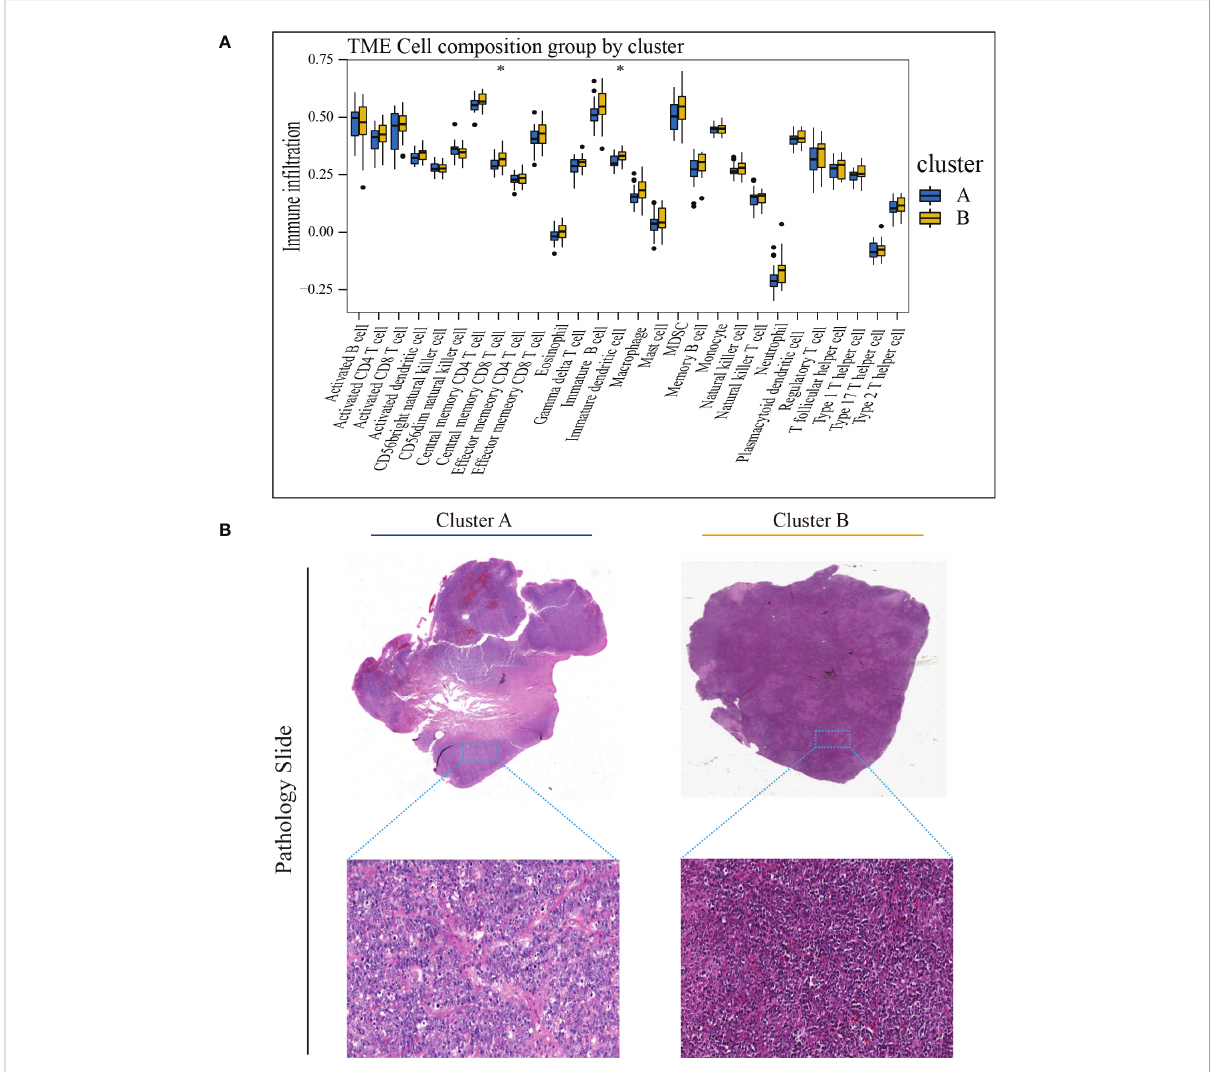
FIGURE 4 Characteristics of TME in the cuproptosis subtypes of TCGA-DLBCL. (A) The abundance of different in fi ltrating immune cells in the two clusters. (B) Representative images of pathological H&E staining of two cuproptosis subtypes. * P < 0.05; ns, not signi fi cant. TME, tumor